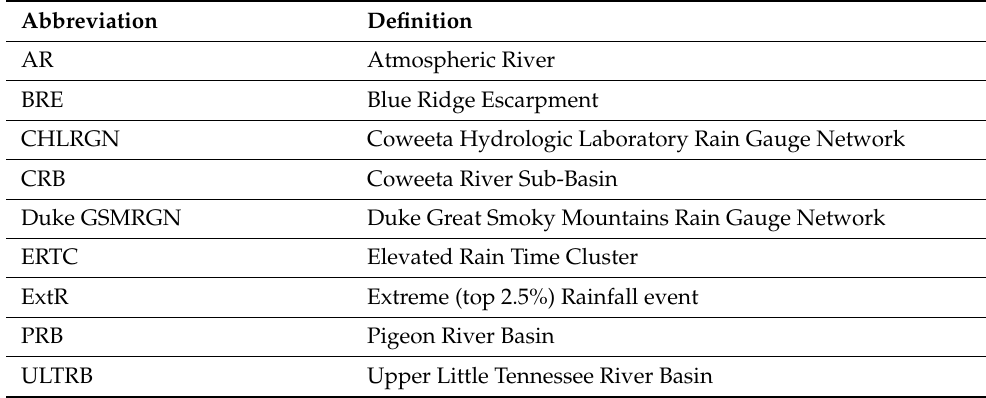
Table A2. List of uncommon abbreviations used in describing the